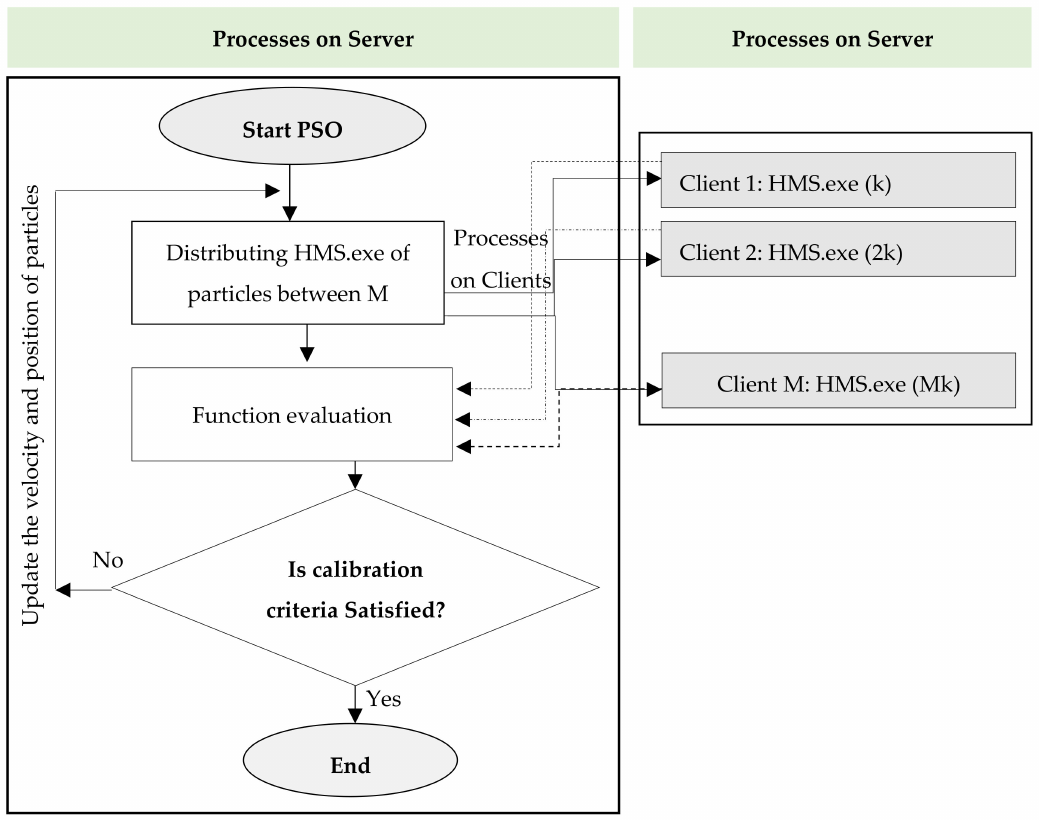
Figure 1. Schematic representation of tasks assigned to the server and different clients for automatic calibration of HEC-HMS (Hydrologic Engineering Center-Hydrologic Modeling